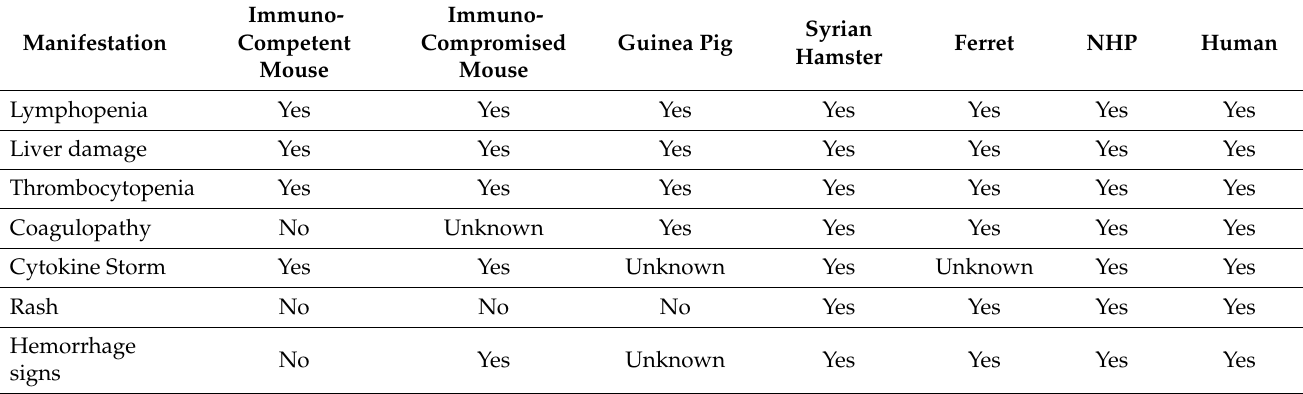
Table 1. Clinical manifestations in different animal models of filovirus infections